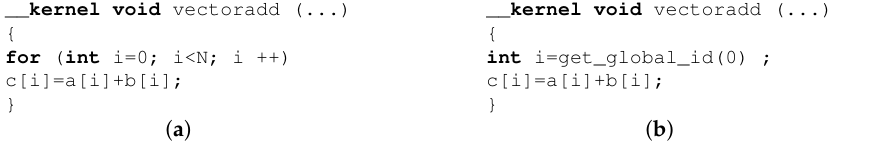
Figure 2. ( a ) Single work-item kernel adding 2 vectors a and b . ( b ) NDRange kernel for vector addition. The n-dimensional range is given in the call in the host